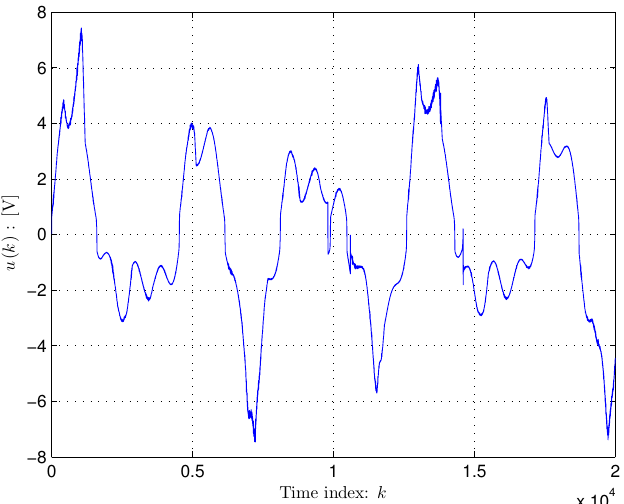
Figure 7. Control effort u ( k ) : with disturbance d s ( k ) .